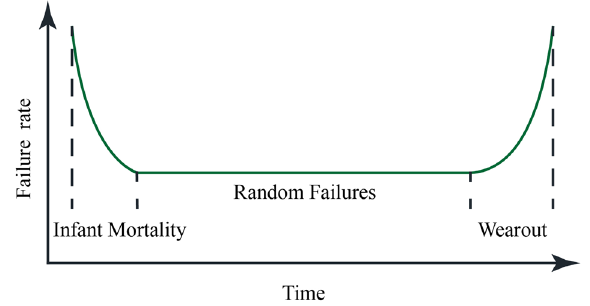
Figure 2. Failure rate "Bathtub